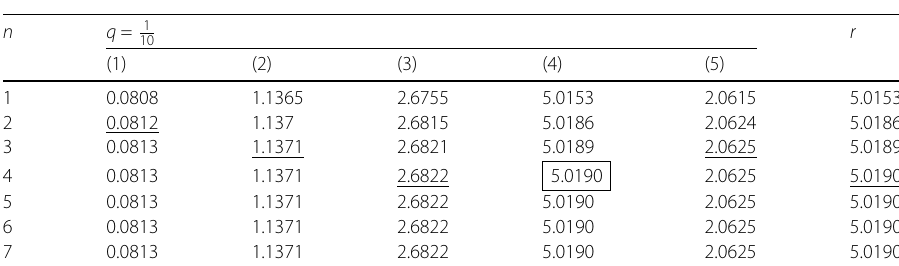
Table 10 Numerical results of (1) = L 1 Λ 1 + | 1 b 0 | and ( i ) = L i Λ i + 2 for q = 1 10